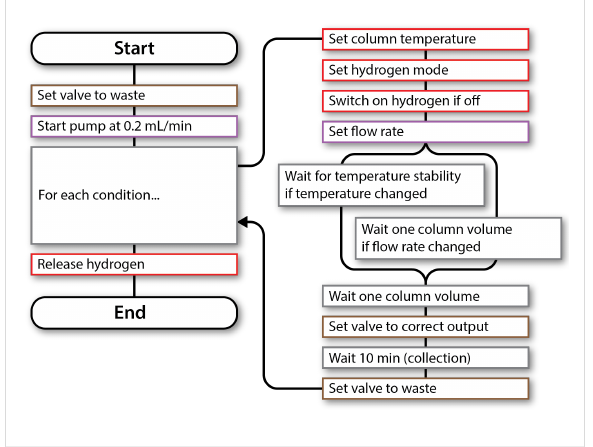
Figure 9: Representation of the control sequence for running experi- ments under a set of conditions. (See Supporting Information File 3 for control